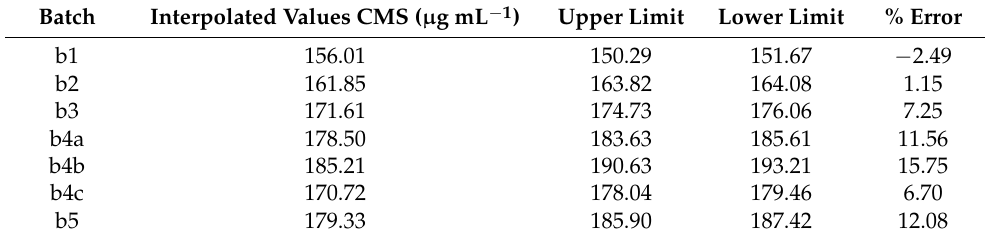
Table 3. Interpolated values and the confidence intervals of Y (jack–knifed) for the tested batches as they were calculated by the developed PLS-R model employing the free software MEPHAS. The % errors from the theoretical value of 160 µ g mL − 1 are also